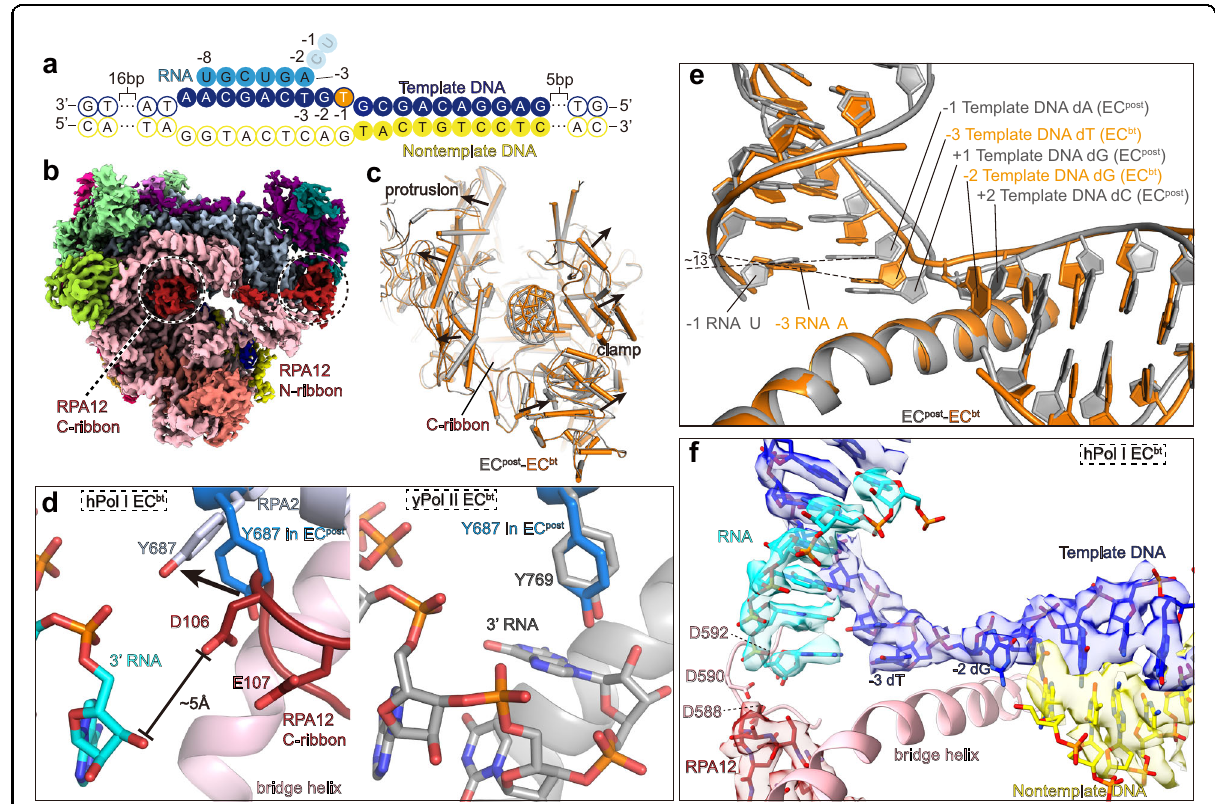
Fig. 4 Structure of Pol I EC in the backtracked state. a Schematic diagram of the transcription scaffold used in assembly of Pol I EC bt . The dA − 1 in template strand was changed to dT − 1 , generating mismatched base pair of DNA – RNA hybrid. The U − 1 and C − 2 of the RNA were cleaved in the assembled EC bt . b Cryo-EM map of EC bt shows that the C-ribbon of RPA12 is inserted into the active site. c Structure comparison shows that the cleft of EC bt (orange) is wider than that of EC post (gray). d Left panel shows the close-up view of the tip of RPA12 C-ribbon in the active site and its interaction with the gating tyrosine and 3 ′ end RNA. Residue Y687 in EC post is shown in sticks and colored in marine. Conformational difference in residue Y687 in the two states is indicated with black arrow. Right panel shows the same view of yPol II EC bt without TFIIS (gray; PDB: 3GTJ) 42 . Residue Y687 in hPol I EC post is shown (marine) for comparison. e Comparison of the DNA – RNA hybrid in hPol I EC bt (orange) and EC post (gray). f Cryo-EM map and structural model of catalytic center of the Pol I EC bt . Cryo-EM map is shown in transparent